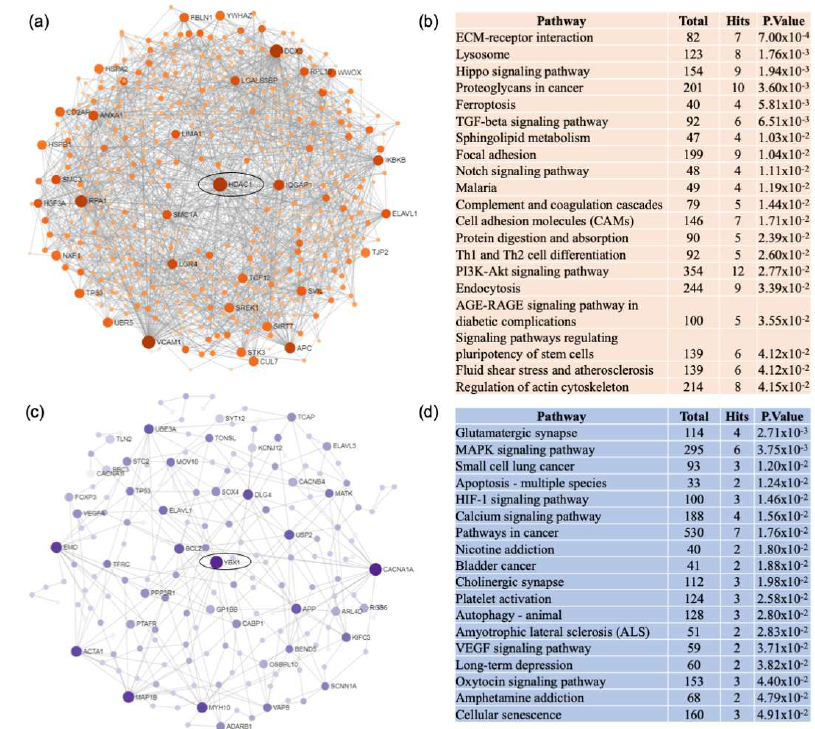
Figure 5. Network and pathway analyses of dysregulated genes in the frontal cortex of FTD patients. Network and pathway were performed on the dataset from FTD patients compared to non-demented controls to identify unique dysregulated pathways in the frontal cortex of FTD. Network and pathway analyses were performed using NetworkAnalyst. Tissue specific networks derived from the protein-protein interaction database from brain frontal cortex were selected. The minimum connected network was analyzed further. Results from the pathway analysis are derived from the Kyoto Encyclopedia of Genes and Genome (KEGG). ( a ) Upregulated genes are shown in orange. Most significant hubs according to degree and betweenness centrality, with the highest number of connections, are enclosed in ovals. ( b ) The 20 top dysregulated pathways ranked according the p-value of significance are presented in the table. Totals refers to the total number of genes that are known to be involved in the KEGG pathway and hits refers to the number of genes identified in this analysis that are involved in the pathway. ( c ) Downregulated genes are shown in blue. Most significant hubs according to degree and betweenness centrality, with the highest number of connections, are enclosed in ovals. ( d ) The 20 top dysregulated pathways ranked according the p-value of significance are presented in the table.